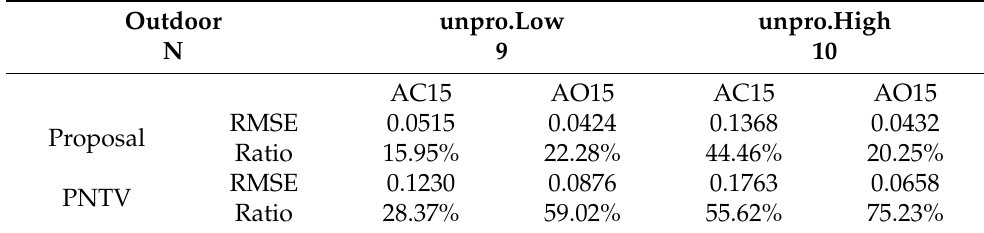
Table 4. The results of outdoor wood